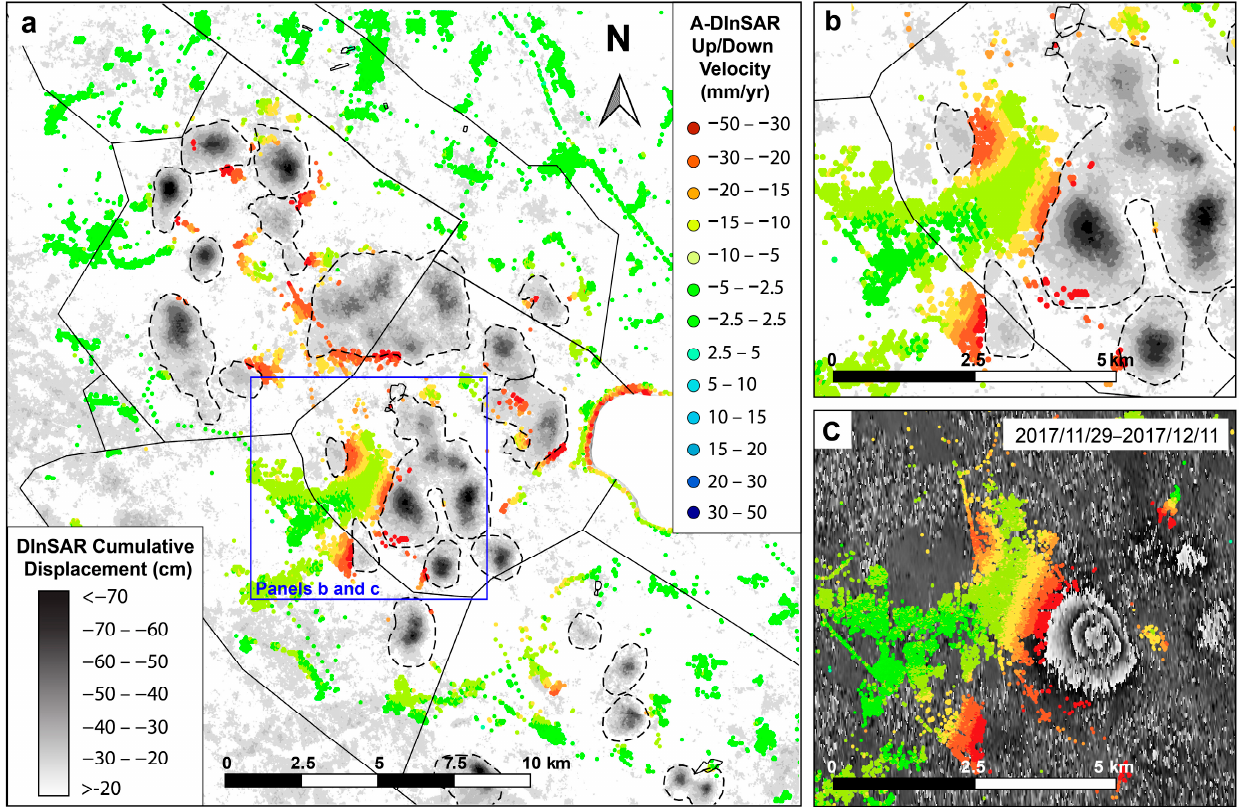
Figure 9. Up/Down A-DInSAR vs. cumulative DInSAR results; ( a ) PSs in up-down direction (October 2014–April 2019) superimposed on the cumulative DInSAR displacement map; the blue box shows the location of the panels b and c; ( b ) zoom on the Polkowice zone; ( c ) PSs in LOS direction superimposed on the interferogram 2017/11/29–2017/12/11 in shades of gray, zoom on the Polkowice zone as in panel b.